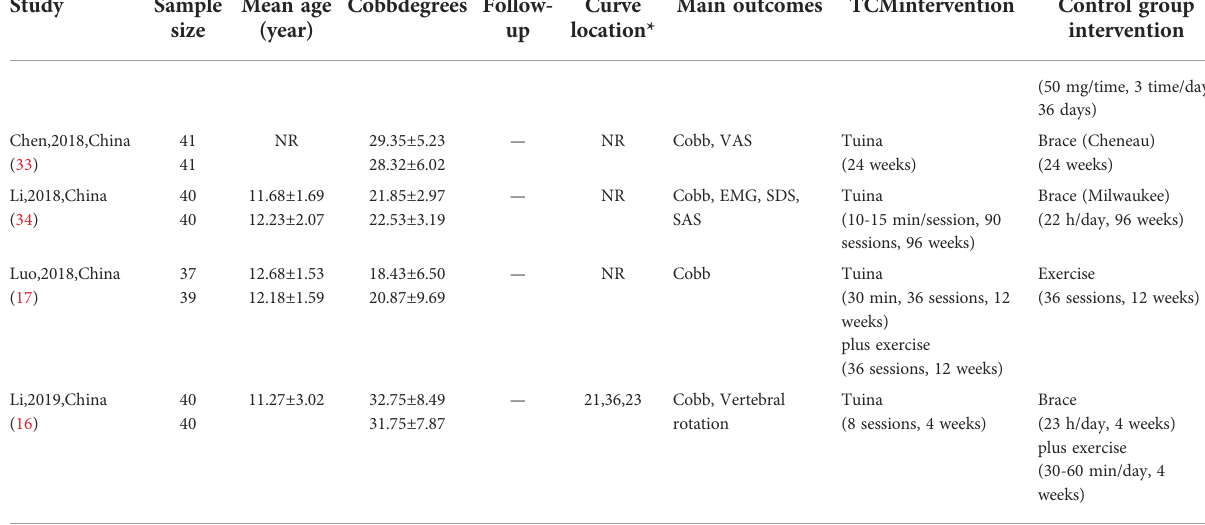
*Main curve location: participants with thoracic curve, thoracolumbar curve, and lumbar curve. QOF, Quality of life; VAS, Visual analogue scale; NR, Not reported; SDS=Self-rating depression scale; SAS, Self-rating anxiety scale; ODI, Oswestry disability index; SRS-22, Scoliosis research society-22; AVR, apical vertebral